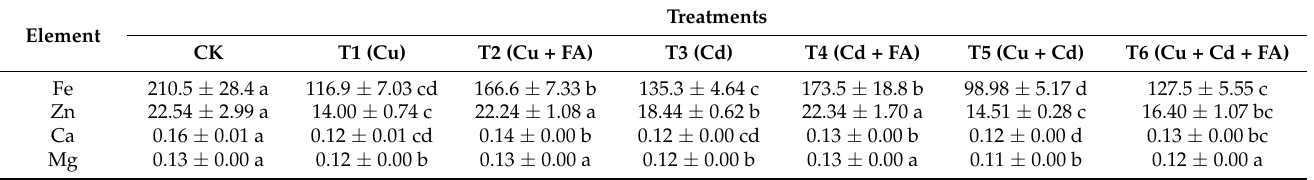
Table 3. The content of Fe, Zn, Ca and Mg of tomato fruits under different Cu, Cd stress (mg · kg − 1 ).